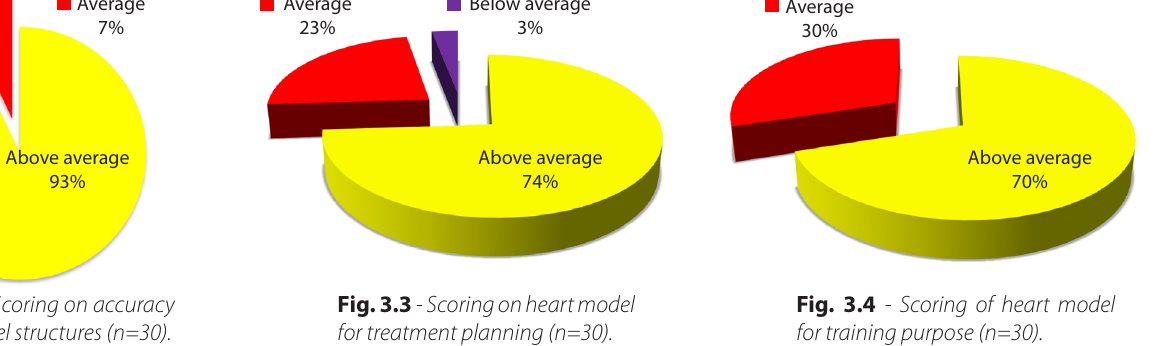
Fig. 3.4 - Scoring of heart model for training purpose (n=30).